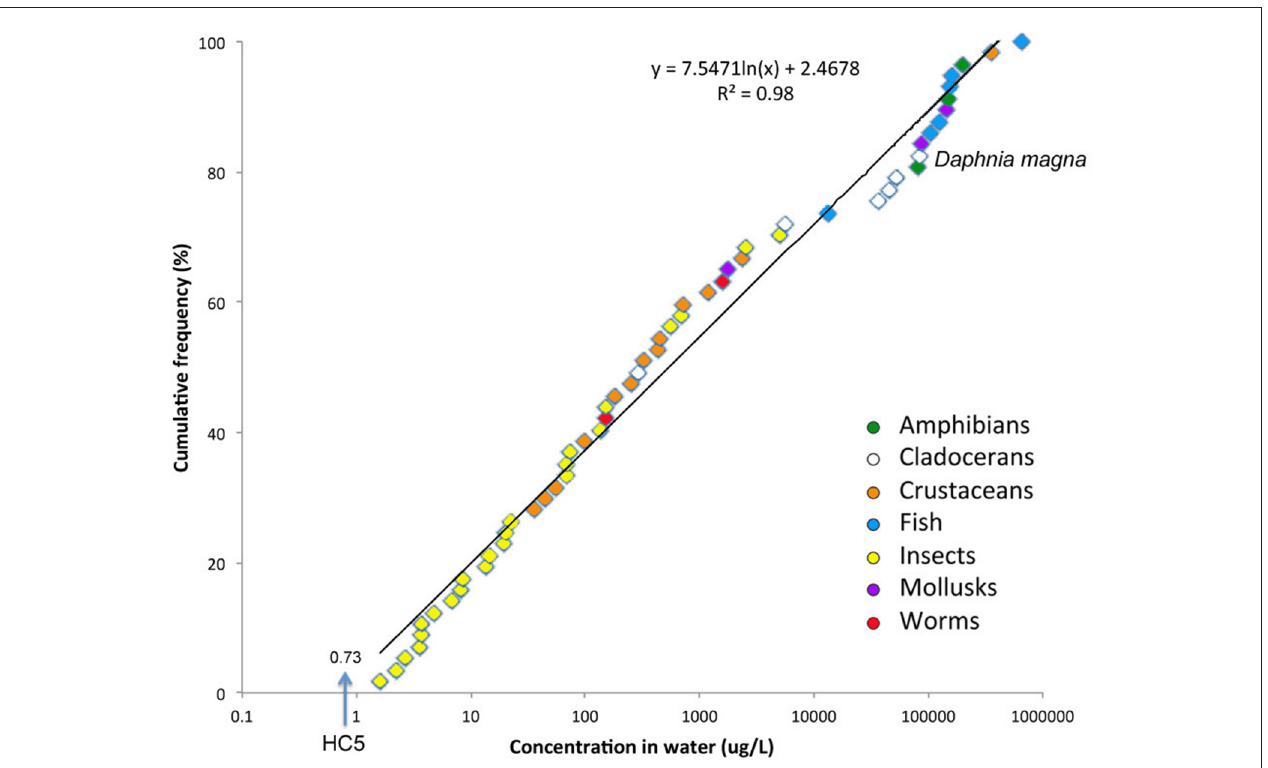
FIGURE 2 | Species sensitivity distribution (SSD) for acute toxicity of imidacloprid (LC50) to aquatic organisms. The hazard concentration affecting 5% of species (HC5, µ g/L) is indicated. Source: ECOTOX database https://cfpub.epa.gov/ecotox/.